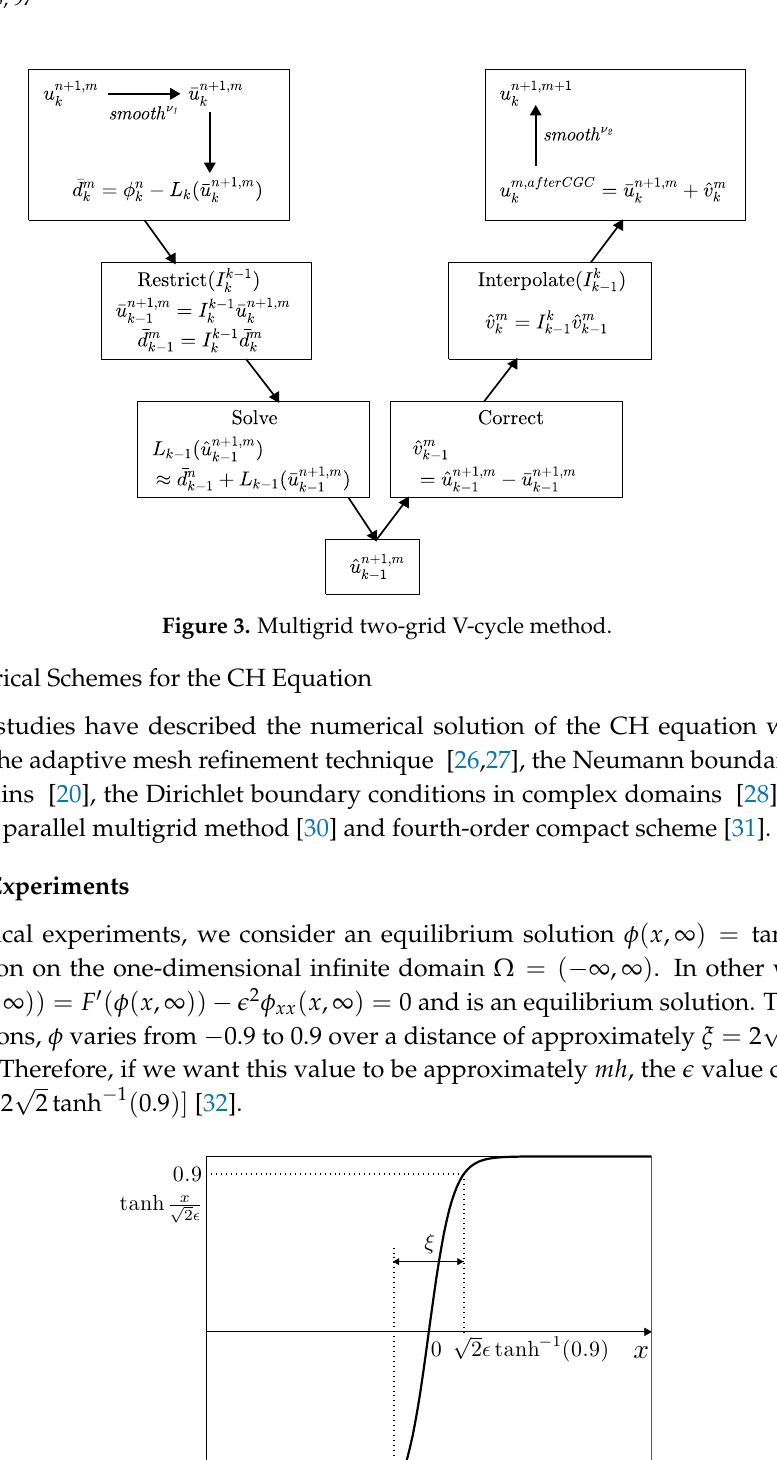
0.9 to 0.9 over a distance of approximately ξ = −